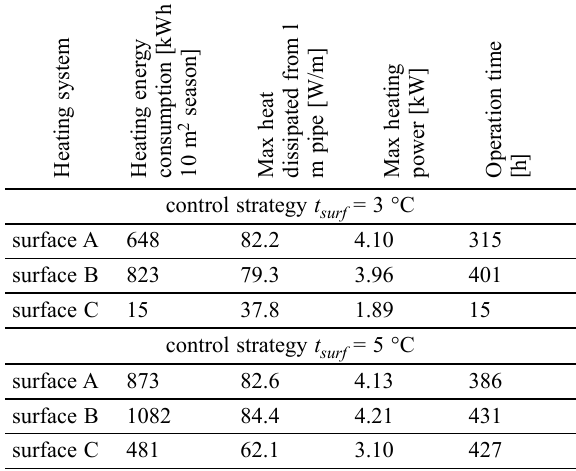
Table 4. Summary of simulation results for different heating surfaces